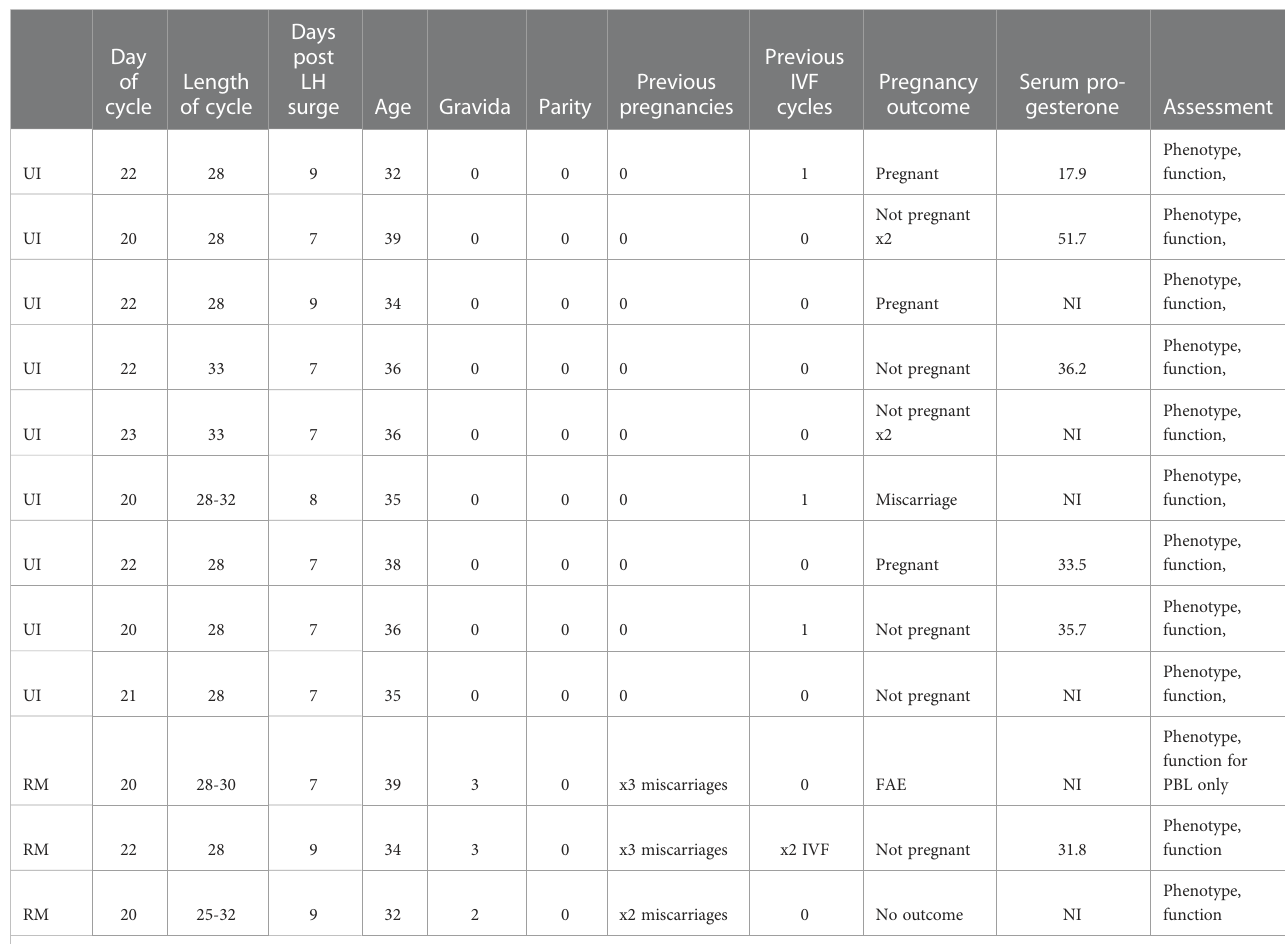
TABLE 1 Research participant